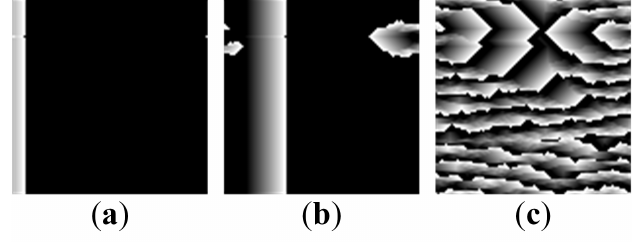
Figure 2. Initial plane vertical wave is induced at left side by pacemaker cells ( a ). However, one cell is dysfunctional and blocks the propagation of the wave front ( b ). Due to the vertical connections between longitudinal cables, the resulting process forms a pattern ( c